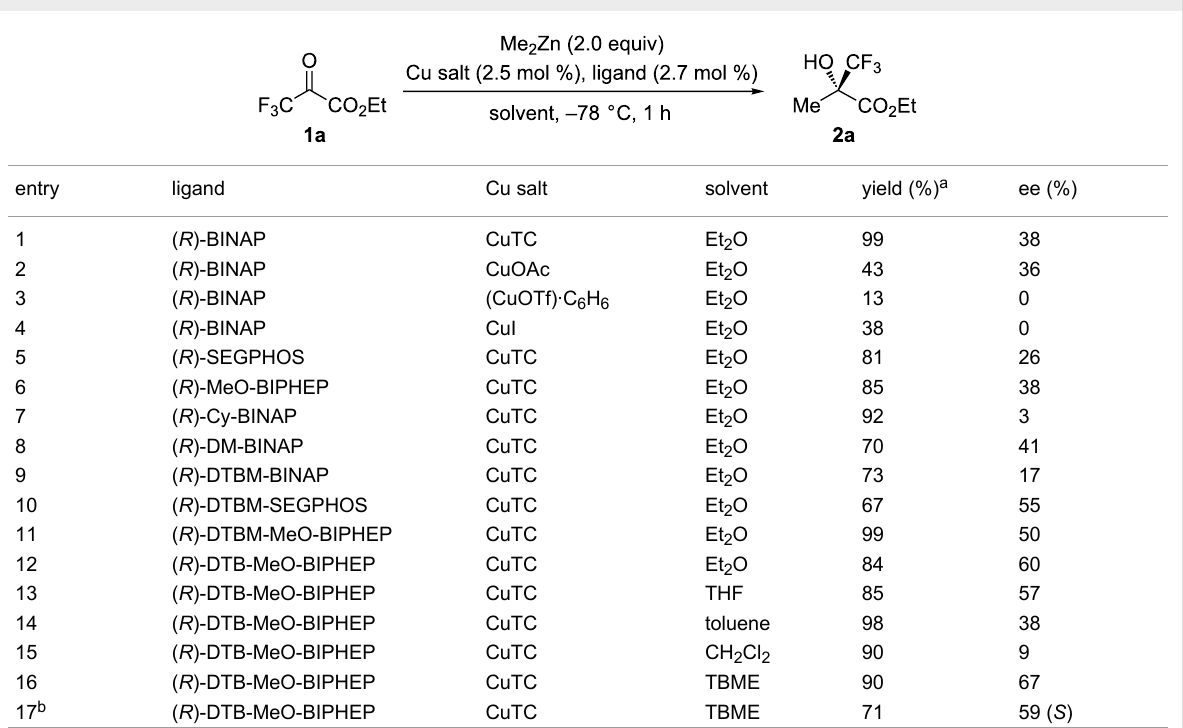
Table 1: Copper-catalyzed asymmetric